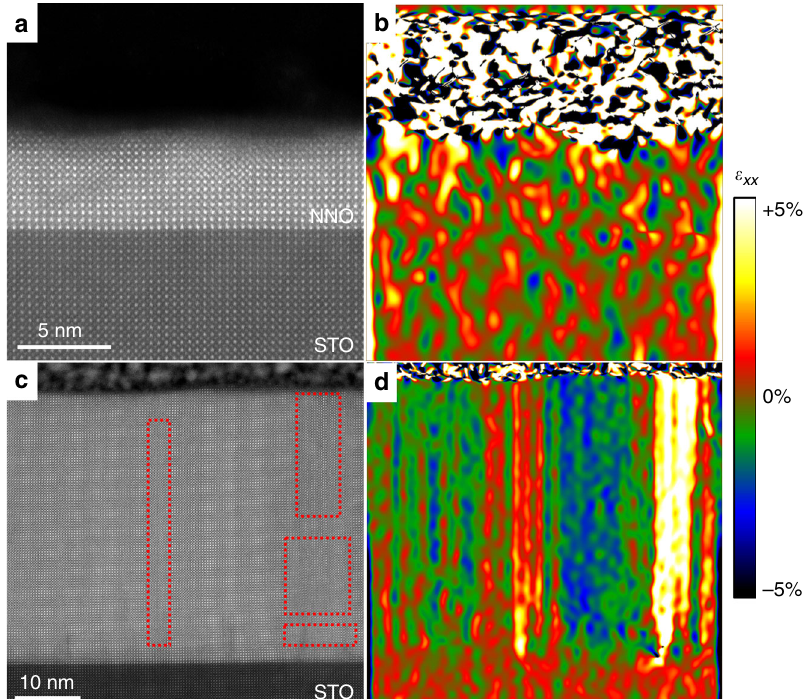
Fig. 5 Atomic image and strain in NNO/STO. Cross-sectional HAADF-STEM image of NdNiO 3 thin fi lms grown on SrTiO 3 substrates, for a 5-nm-thick fi lm ( a ) and a 40-nm-thick fi lm ( c ). The respective in-plane components of the strain tensor ( ε xx , colour scales) obtained from the STEM images by geometrical phase analysis (GPA) are shown in b and d . The red dashed lines surround the RP faults.